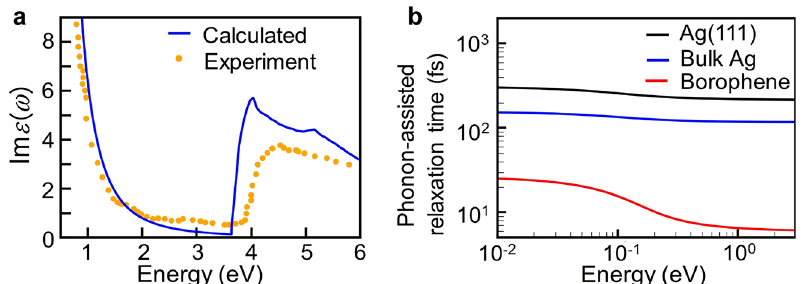
Figure 3: Frequency-dependent momentum relaxation times of Ag(111) monolayer, bulk Ag, and borophene monolayer. (a)Imaginarypartofthedielectricfunctionobtainedbyexperimentalmeasurementandourcalculation,asafunctionofphotonenergy,inbulk Ag. (b) Momentum relaxation times of phonon-assisted intraband electronic excitations, as a function of photon energies, in Ag(111) monolayer, bulk Ag, and borophene monolayer.